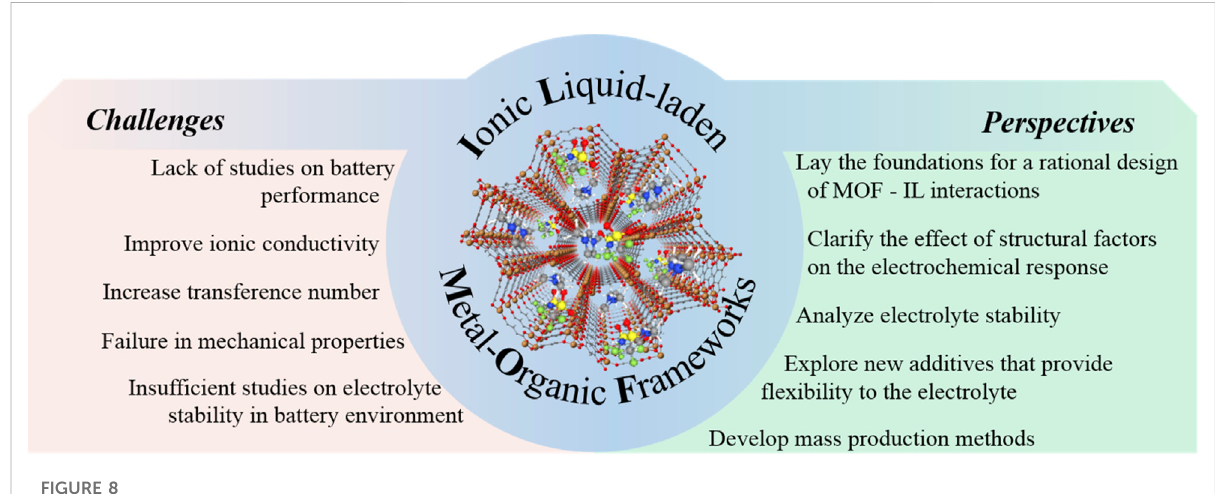
FIGURE 8 Challenges and perspectives for the development of IL-laden MOFs as (quasi)solid-state